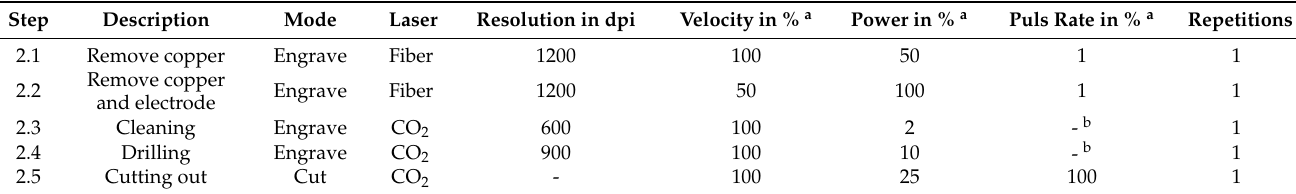
Table 3. Laser system parameters for manufacturing the stretchable circuit board.